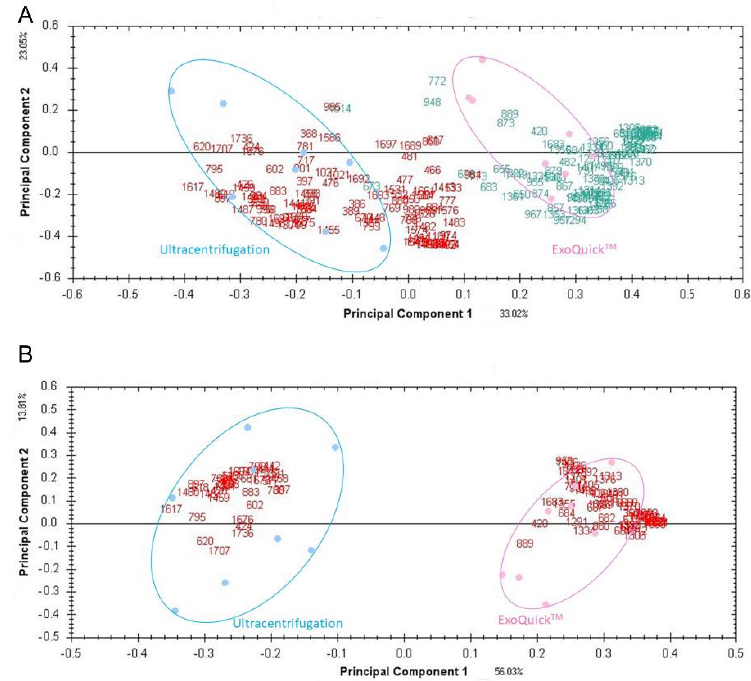
New corrected Figure 2 for